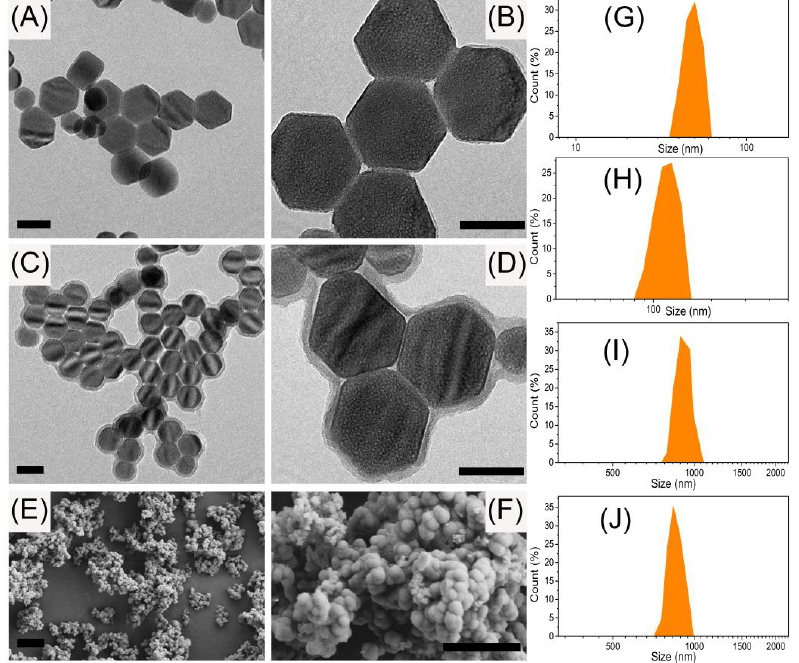
Figure 3. ( A , B ) The typical HRTEM photographs of the as-prepared β-NaYF 4 : Yb 3+ , Er 3+ upconversion nanocrystals; ( C , D ) The typical HRTEM photographs of the UCNPs@SiO 2 nanocrystals; ( E , F ) The typical SEM images of the obtained UCNPs@SiO 2 @MIP polymeric materials. The scale bars represent 50 nm ( A – D ) and 2 μ m ( E , F ), respectively; The size distribution of UCNPs ( G ), UCNPs@SiO 2 ( H ), MIPs ( I ), and NIPs ( J ) obtained via